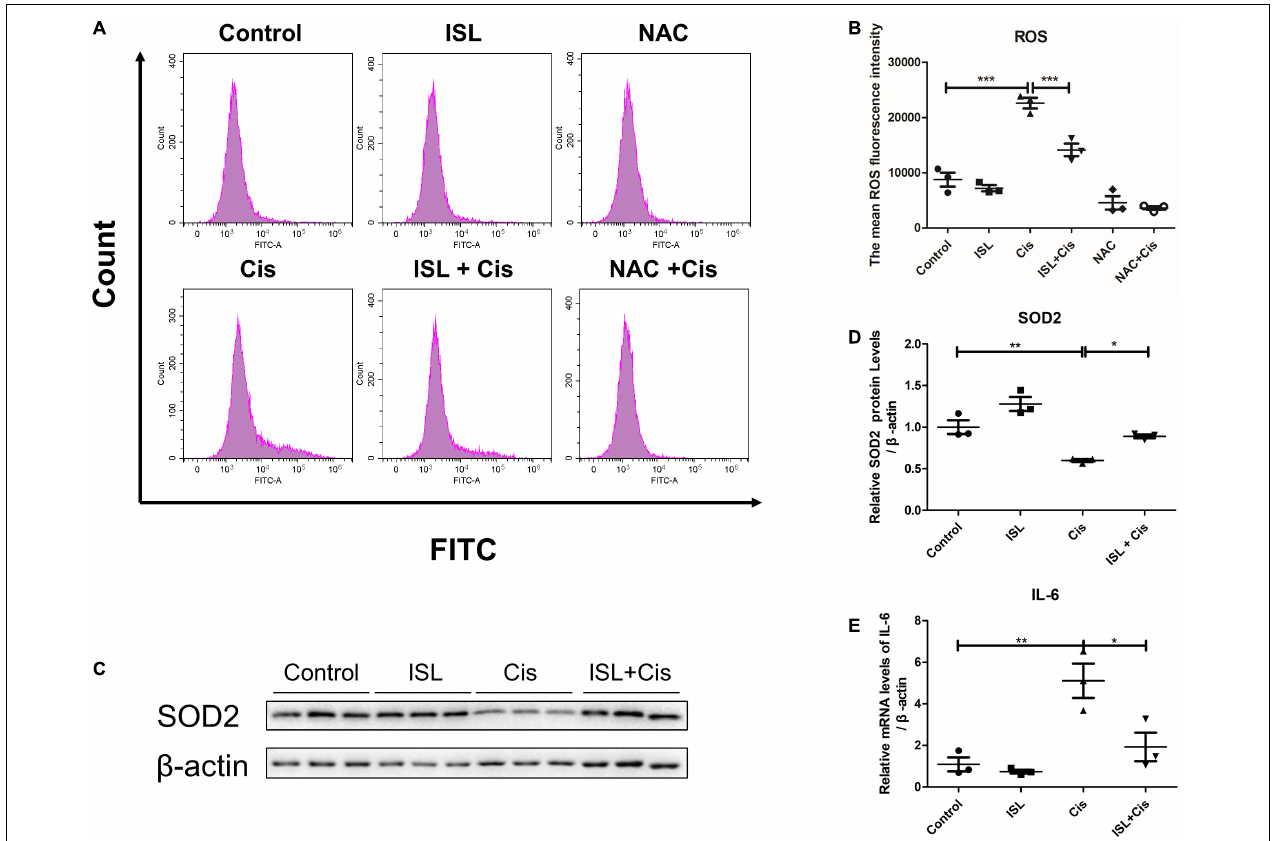
FIGURE 3 | ISL suppressed cisplatin-induced oxidative stress and inflammation in mPTCs. (A) The representative images of the flow cytometry data of ROS assay in mPTCs. The mPTCs were pretreated with 62.5 µ M ISL for 6–8 h, and then were administered 5 µ g/mL cisplatin for 24 h. (B) Quantitation of the mean fluorescence intensity ( n = 3 per group). (C) Representative western blots of SOD2 protein levels of mPTCs pretreated with 62.5 µ M ISL for 6–8 h and administered 5 µ g/mL cisplatin for 24 h. β -actin was used as an internal reference. (D) Densitometry analysis of the western blots of SOD2 ( n = 3 per group). (E) The mRNA level of IL-6 was detected by QRT-PCR. The quantitative results are expressed as mean ± SD of each group. * p < 0.05, ** p < 0.01, *** p < 0.001 (ANOVA with multiple